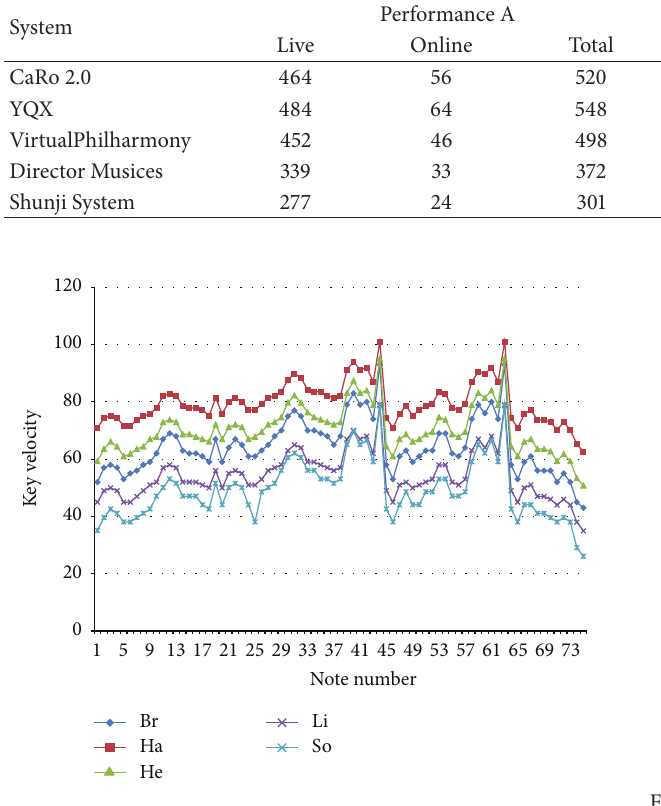
Figure 13: The Key-Velocity values of the performances charac- terised by the different expressive intentions (bright, hard, heavy, light, and soft). Only the melodic line is reported in order to have a more readable graph.